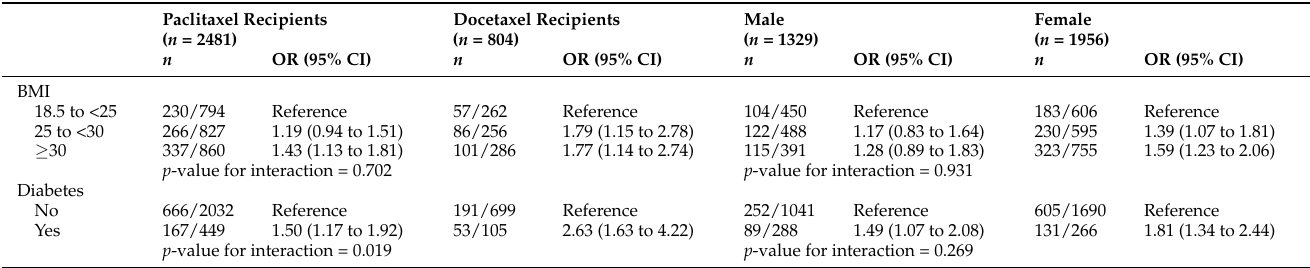
Table 3. Association of neuropathy with patient demographic and clinical characteristics stratified by type of taxane and sex.